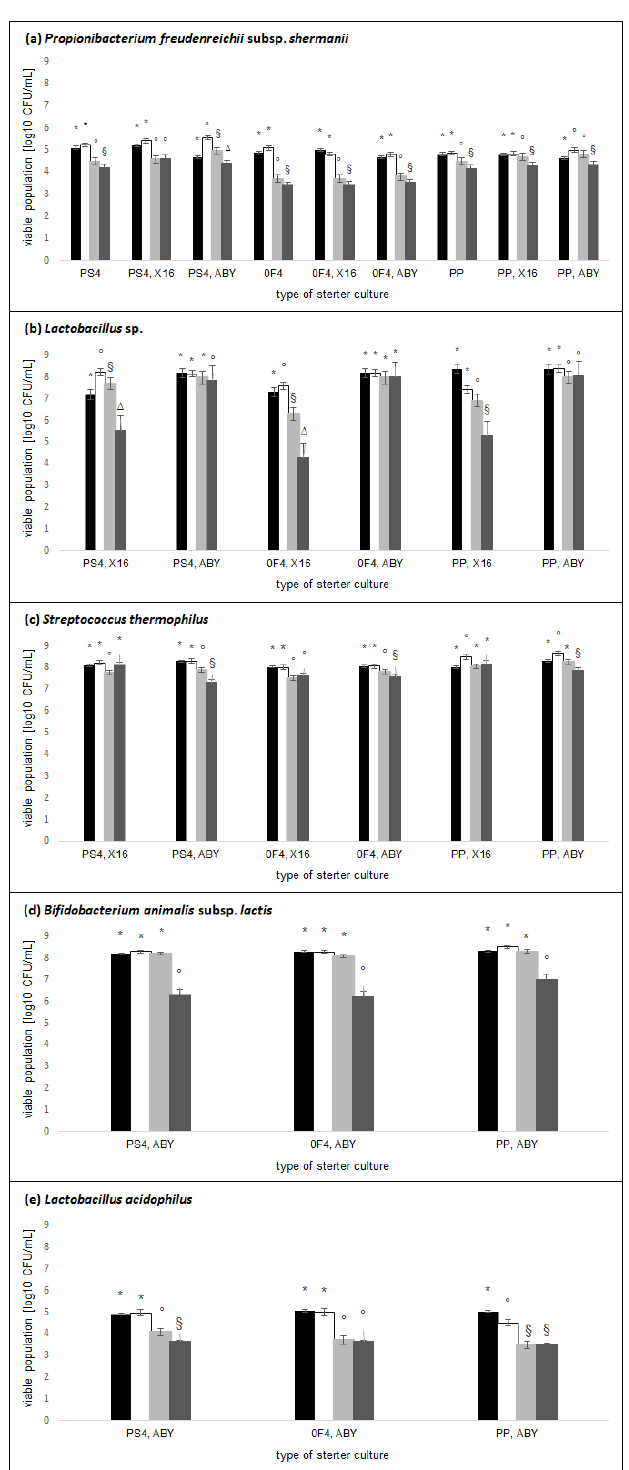
Figure 2. The changes in the viable bacteria population of Propionibacterium freudenreichii subsp. shermanii, Lactobacillus sp., Streptococcus thermophilus, Bifidobacterium animalis subsp. lactis, and Lactobacillus acidophilus in rice-based beverages before fermentation (black column), after fermentation (white column), after 14 days of storage (light grey column), and after 28 days of storage (dark grey column) when inoculated with different starter cultures. Within each starter culture, the group means with a common symbol are not significantly different ( p ≥ 0.05). Error bars represent standard error of the